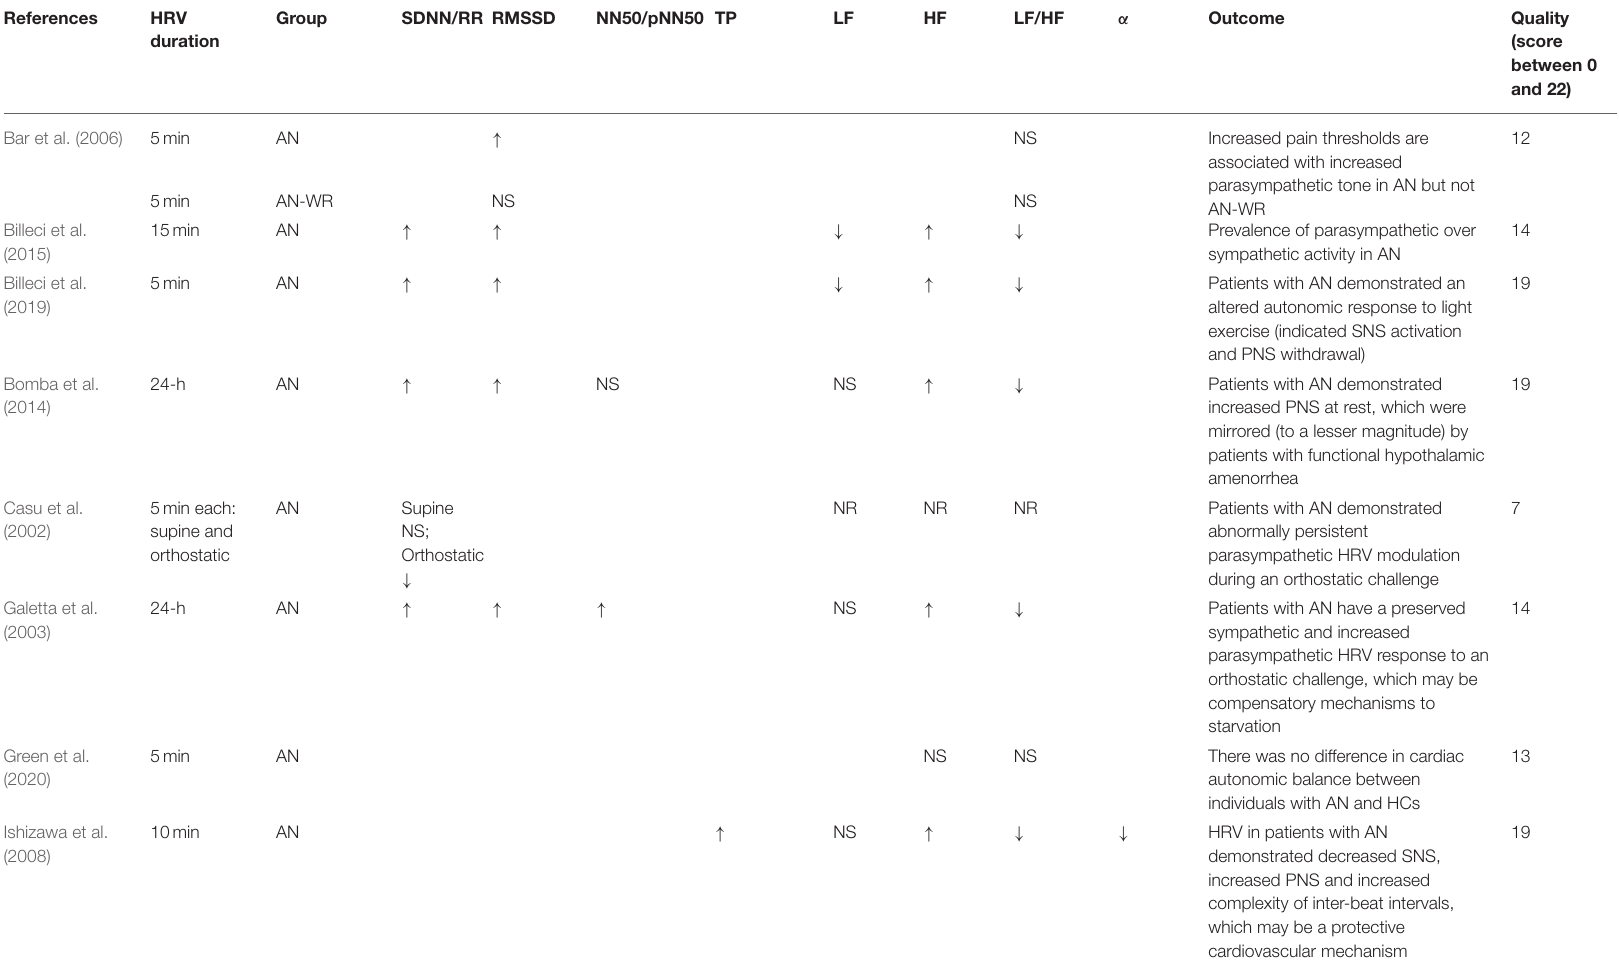
TABLE 3 | Heart-rate variability, as compared to